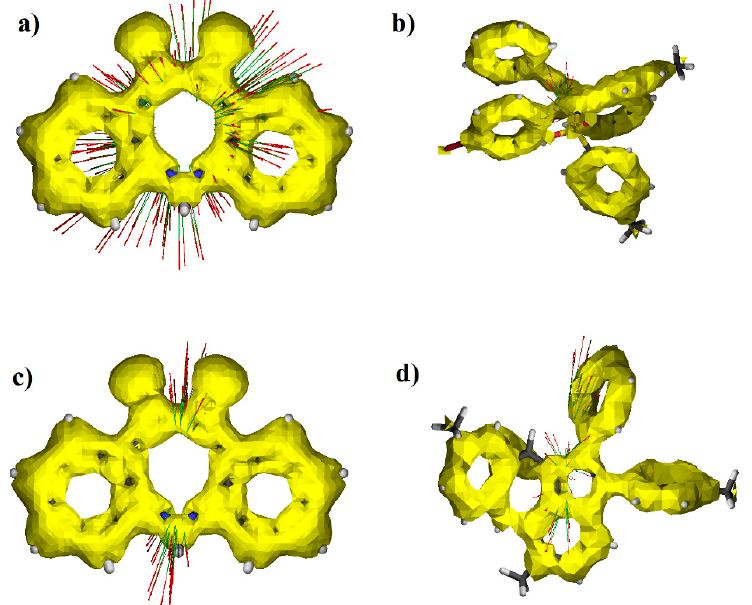
Figure 9. ACID surfaces for selected 10,11-dihydro-5 H -dibenzo[b,f]azepine derivatives with dif- ferent aromaticity of the central ring: GEXMAA01 [69] (0.7355) ( a ), RONRAQ [70] (0.7088) ( b ), GEXMAA [71] (0.6981) ( c ), TEVKUC [72] (0.6269) ( d ). In parentheses are given the HOMED values for the middle